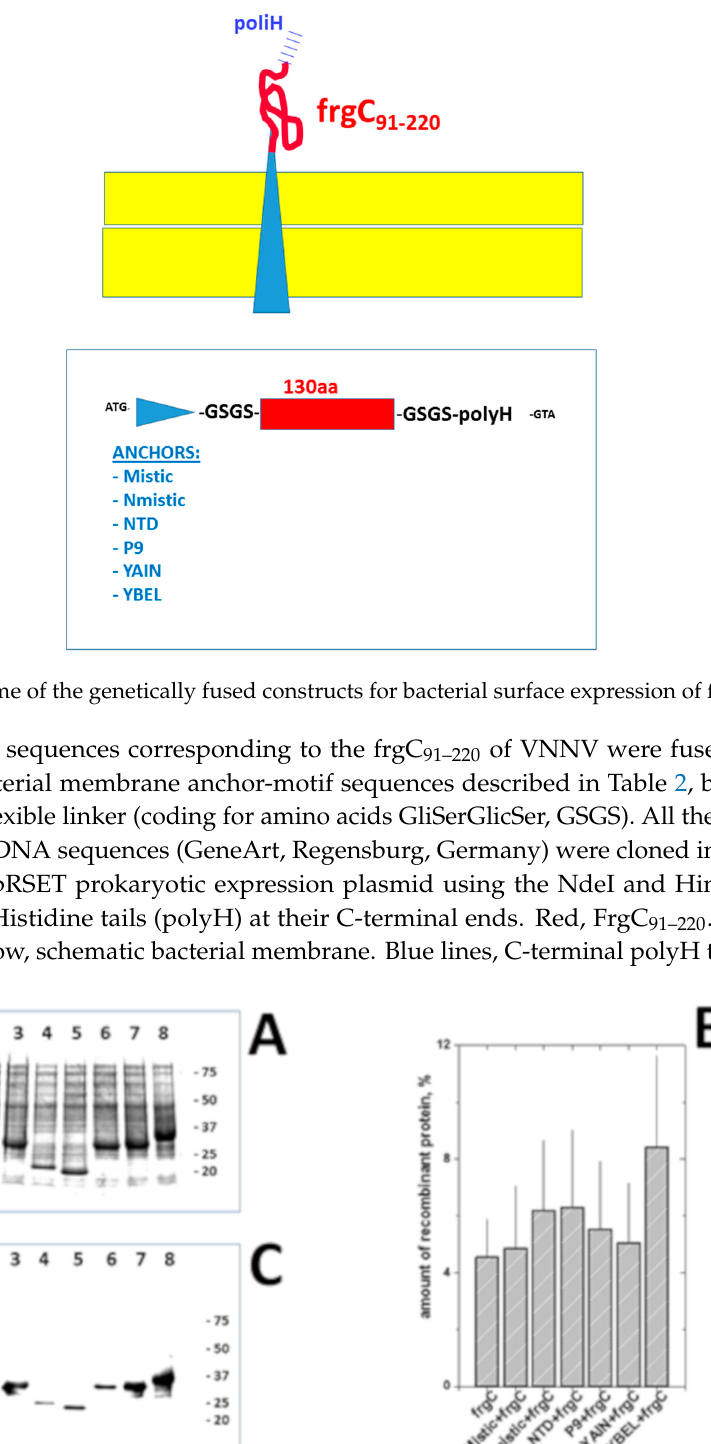
Figure 3. Coomassie-blue staining ( A,B ) and Western blotting ( C ) of anchor-motif+frgC 91–220 spinycterins grown and autoinduced in SB medium.